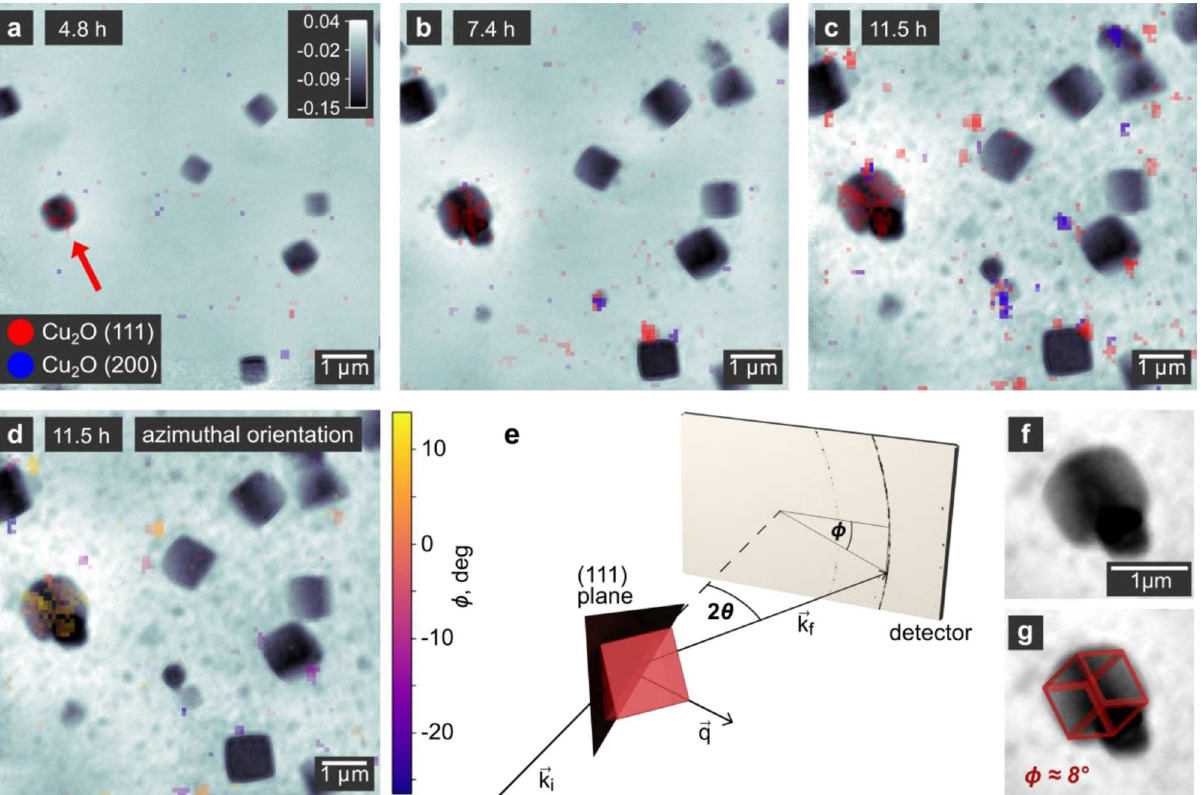
Figure 2. Crystallinity of growing Cu 2 O nanocubes. ( a – c ) In situ ptychographic reconstructions during the growth of the Cu 2 O nanocubes overlaid with the spatially resolved nano-diffraction signal. The crystallographic orientation is highlighted by color, whereas the gray scale indicates the phase shift of the object in radian as obtained by ptychography. While most of the single-crystalline nanocubes are oriented in a way not fulfilling the Bragg condition, the particle marked with an arrow diffracts at the (111) plane. ( d ) Same ptychographic reconstruction as in c , but here the overlay indicates the azimuthal orientation of the (111) crystallographic plane. The highlighted particle exhibits an azimuthal rotation of φ ≈ 8 ◦ . ( e ) Schematic illustration of the single- −→ −→ −→ k i , the diffracted beam q k f and the scattering vector particle diffraction geometry showing the incident beam